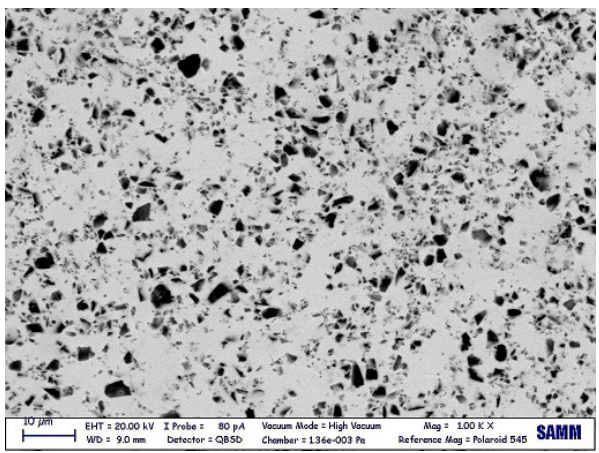
Figure 4. Gf microstructure, as observed via a SEM.